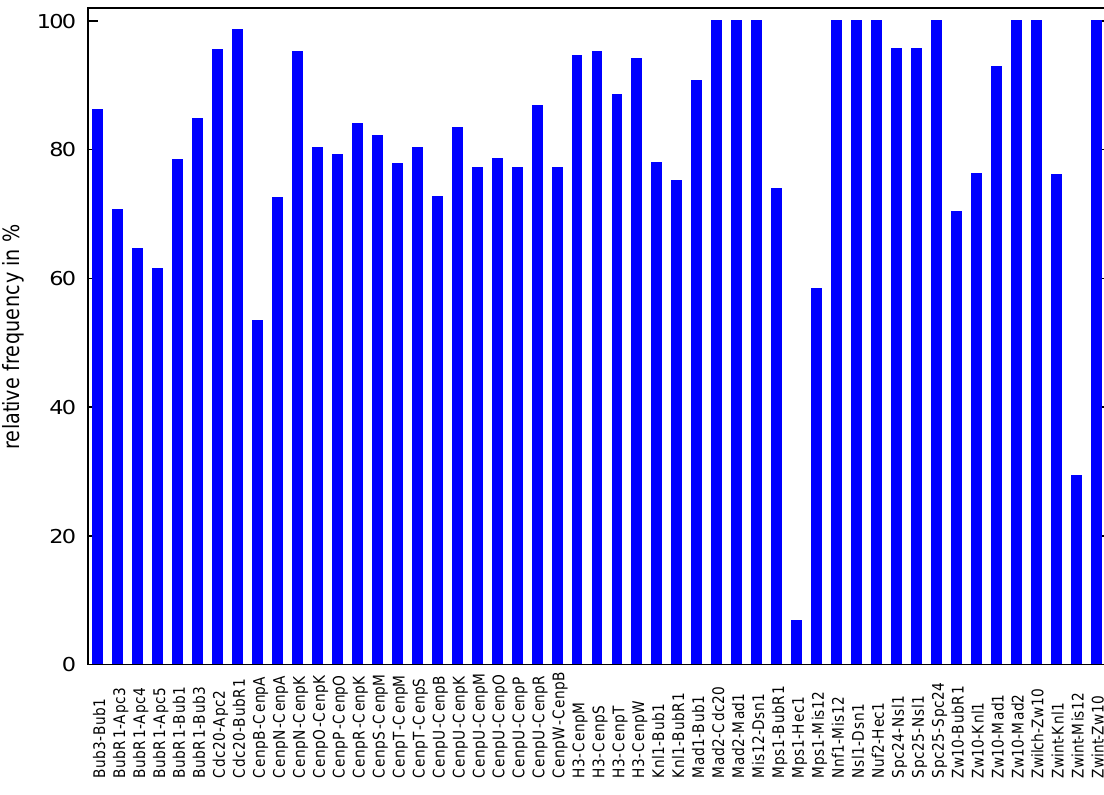
Histogram showing percent of number of possible bindings. We record all realized bonds at the final time-step ( 6 × 10 6 ) of each of the 200 simulations. The maximum usually is 1,200, because every protein occurs six times per simulation, except CenpA (once) and CenpN (two times). In the graphic presented here, the relative frequency of every possible binding is depicted. The histogram shows that all reactions were often realized, except Mps1-Hec1 and Zwint-Mis12 (for details, see Section 3.2.3. Simulation time for